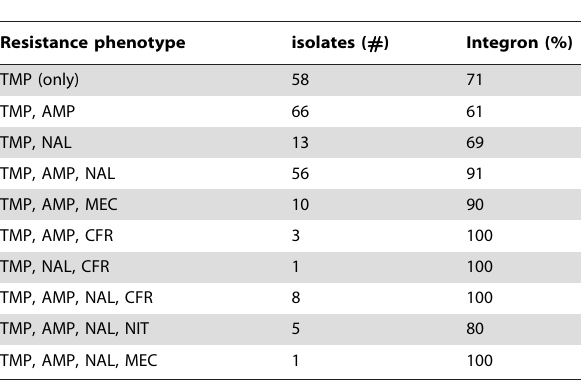
Table 5. No. of E. coli (n= 320) isolates resistant to trimethoprim only and in combination with other antibiotics and in relation to the presence of integrons.